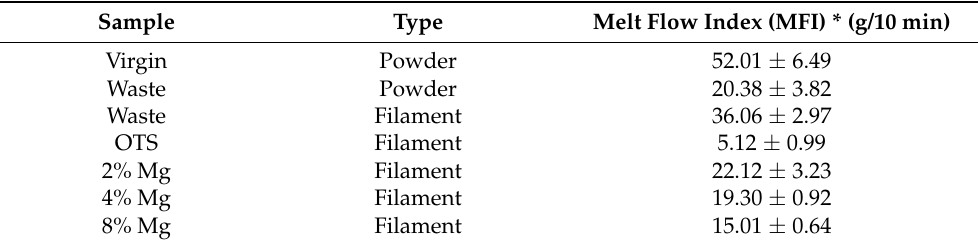
Table 2. Melt flow index